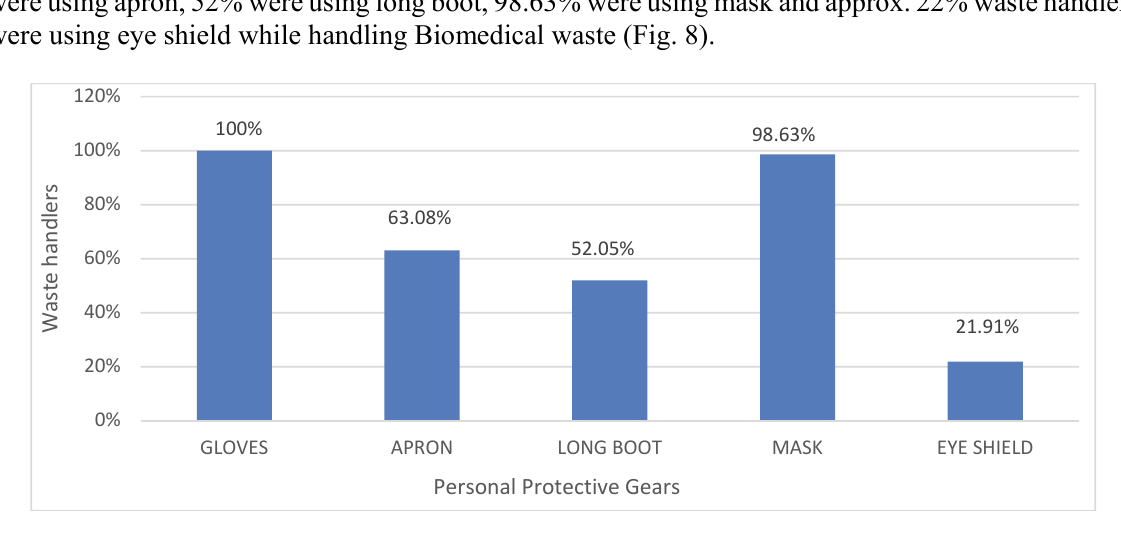
Fig. 8. Use of PPGs while handling Biomedical